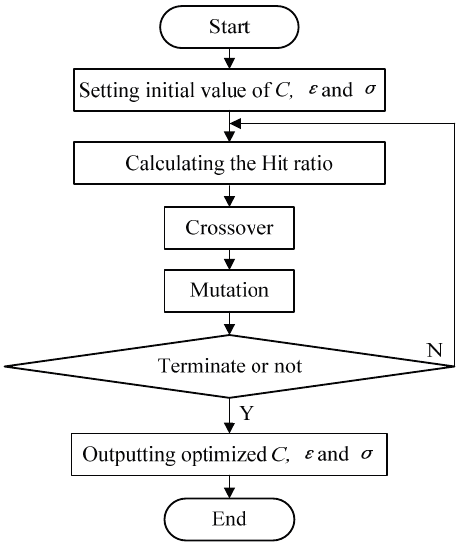
Figure 3. The basic procedure of